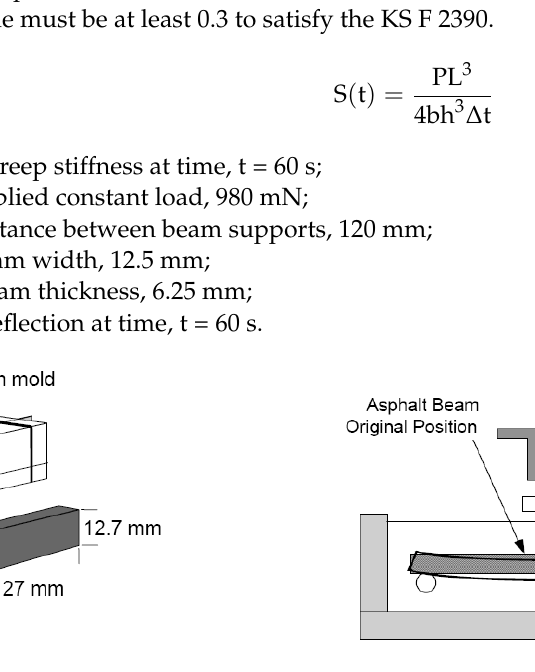
Figure 8. The specimen and testing setup for the BBR test.